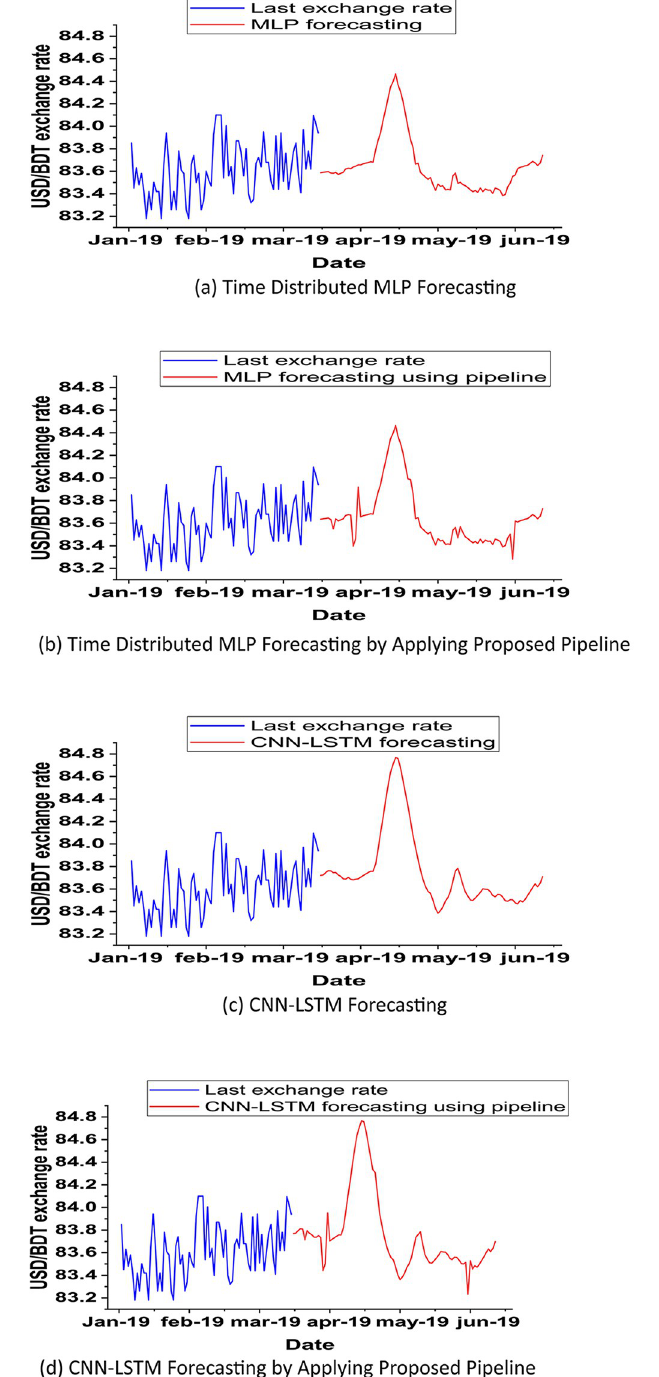
Fig 3. Forecasting the USD/BDT exchange rate by using our best two models. (a) Time distributed MLP, (b) by applying the proposed pipeline on Time Distributed MLP, (c) CNN-LSTM, and (d) by applying the proposed pipeline on